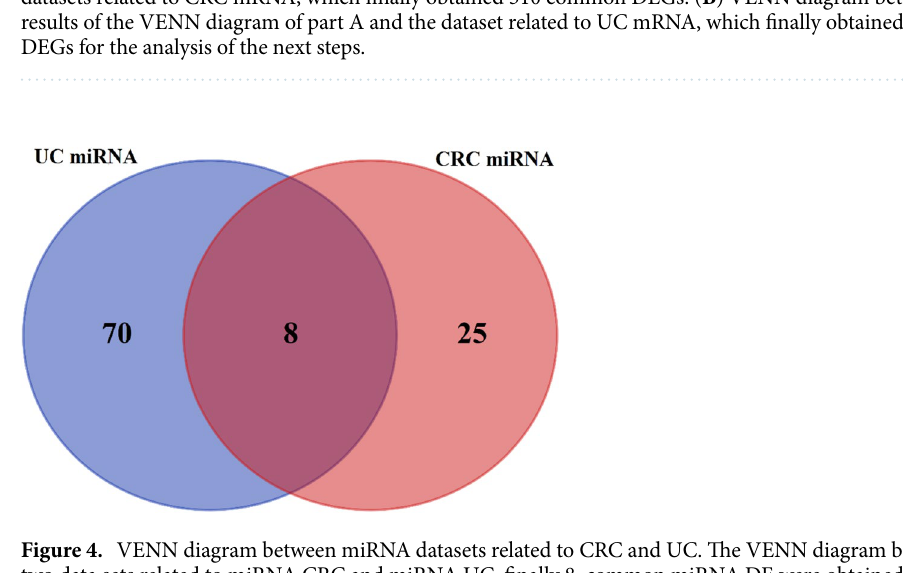
Figure 3. VENN diagram between CRC and UC related mRNA datasets. ( A ) VENN diagram between two datasets related to CRC mRNA, which finally obtained 510 common DEGs. ( B ) VENN diagram between the